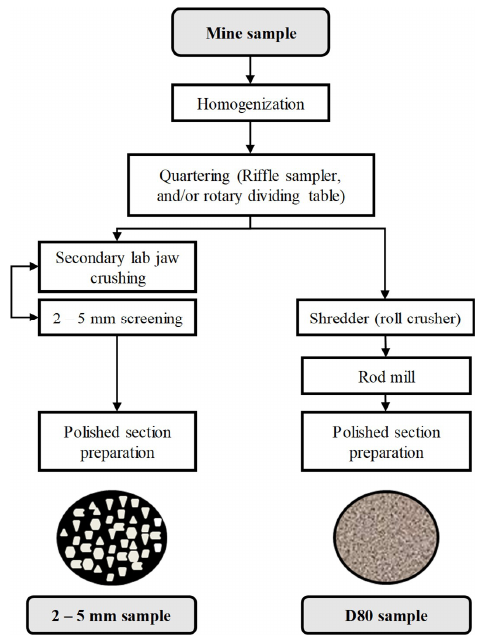
Figure 1. Lab preparation procedure to obtain the two different polished